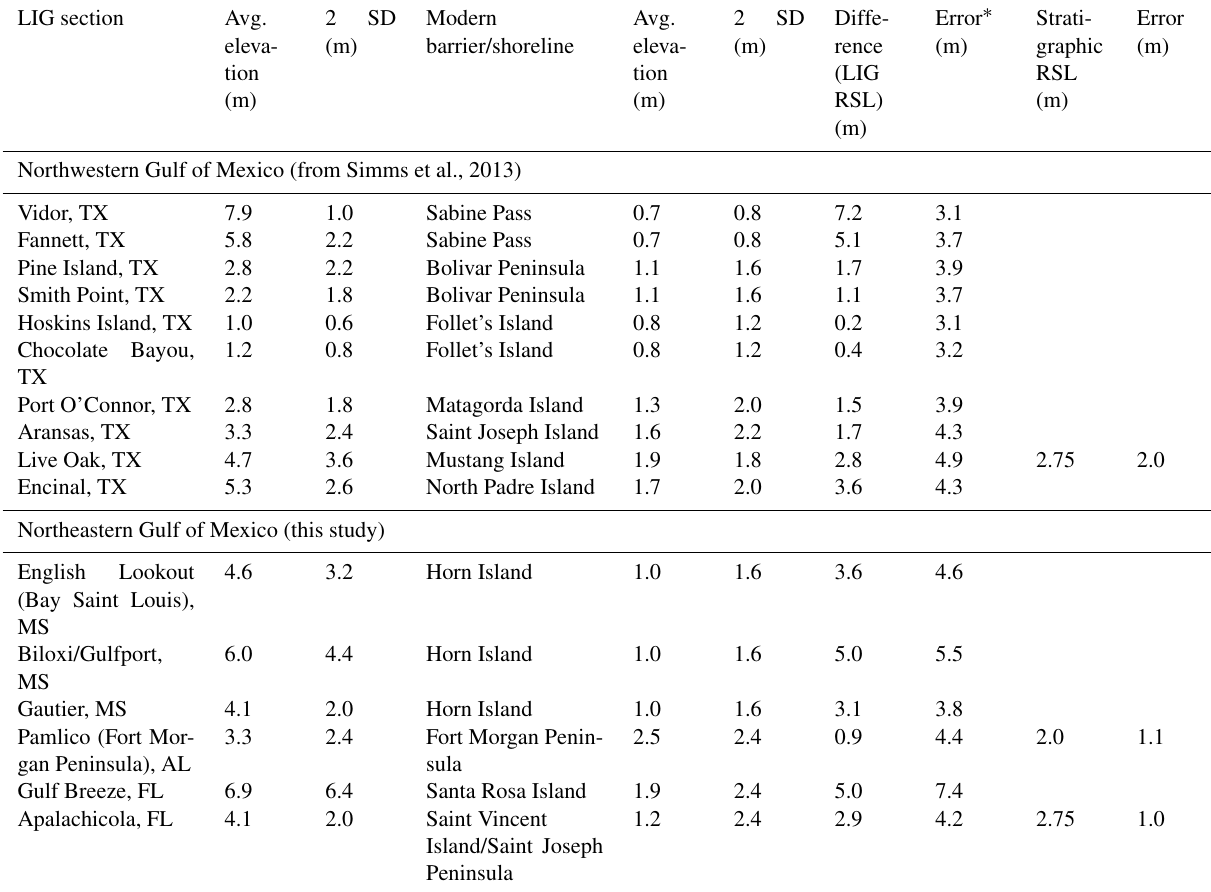
Northeastern Gulf of Mexico (this